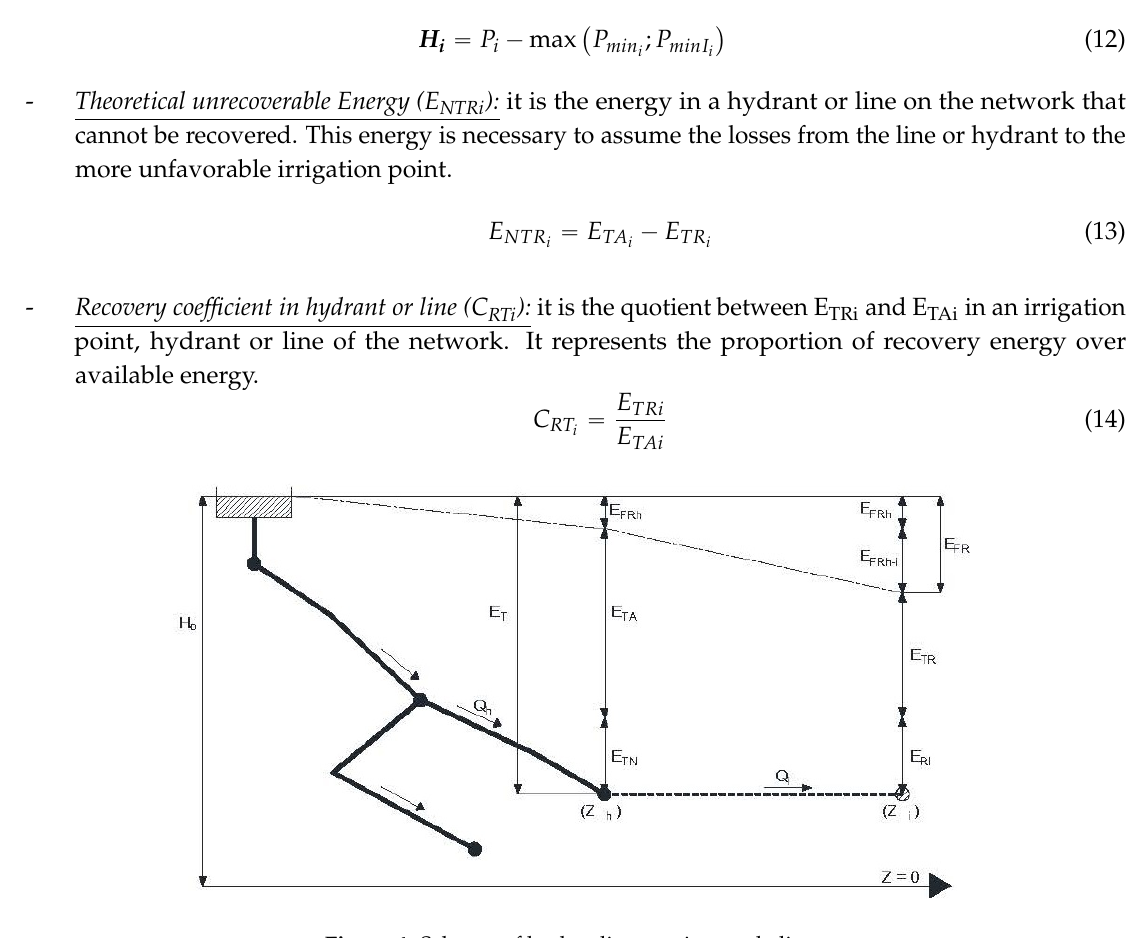
Figure 4. Scheme of hydraulic energies grade line.